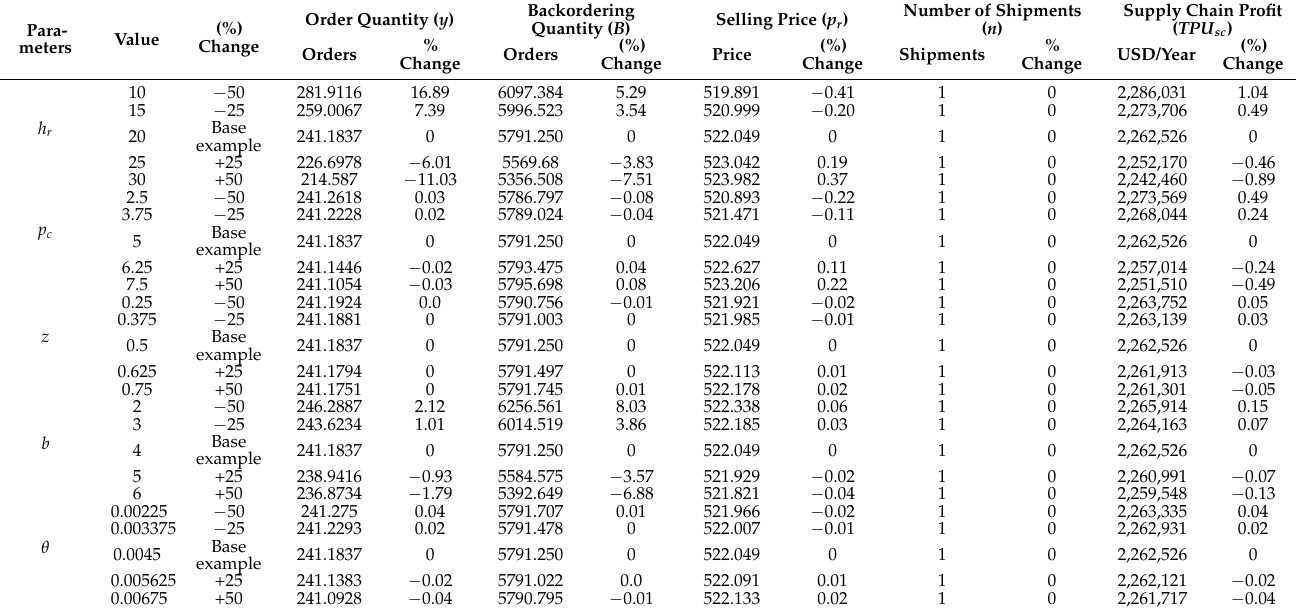
Table 5. Impacts of the costs of the inventory system ( h r , p c , z , b , θ ) on the optimal solution.